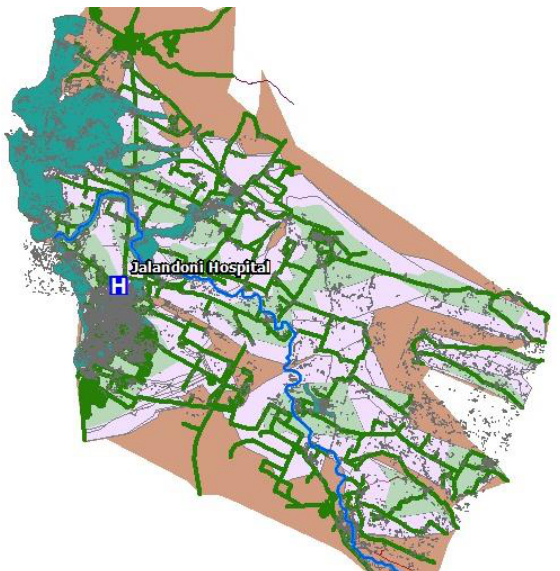
Figure 7. Map of safety facilities within the high flood susceptibility area.